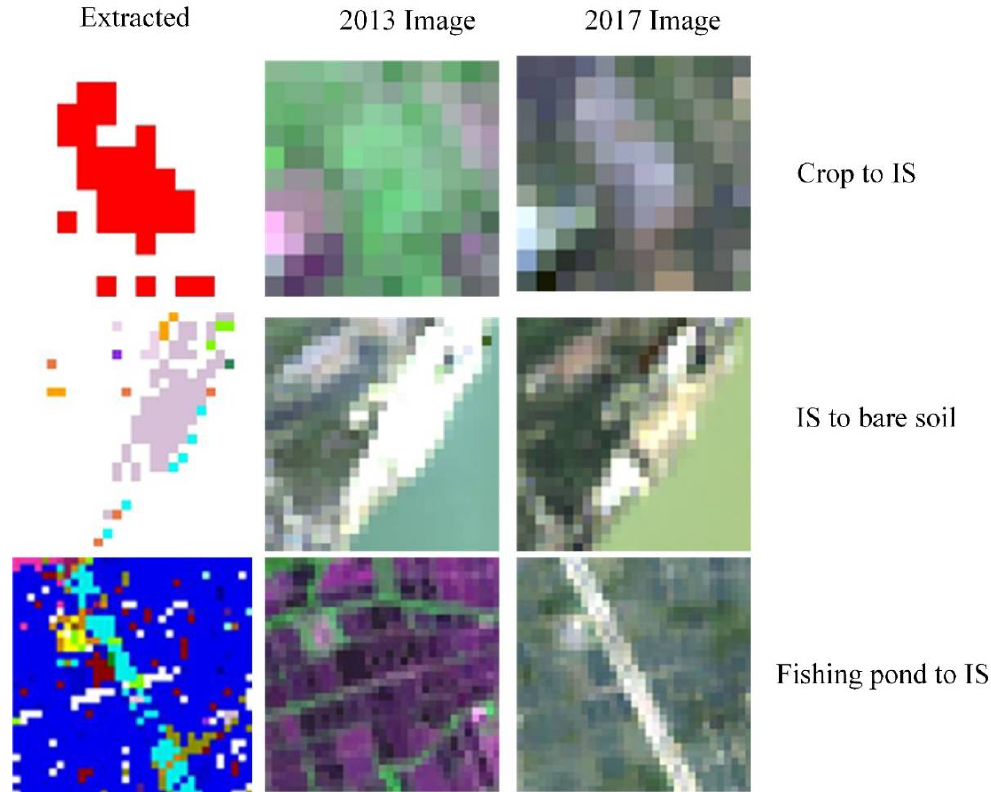
Figure 6. Examples of typical transitions to and from Impervious Surface.